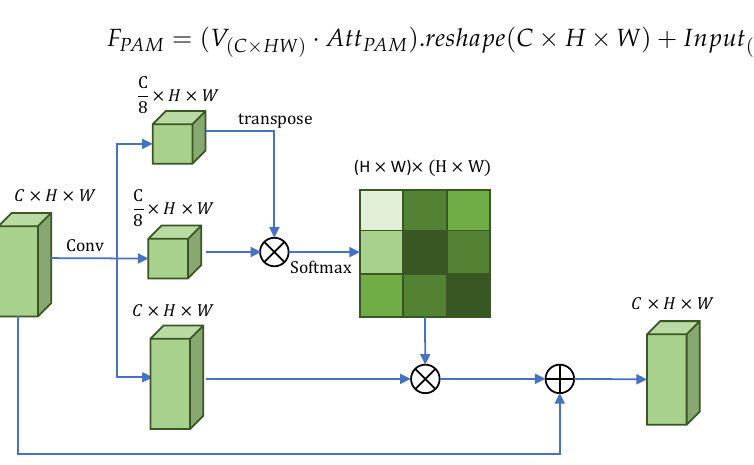
Figure 5. Illustration of the structure of